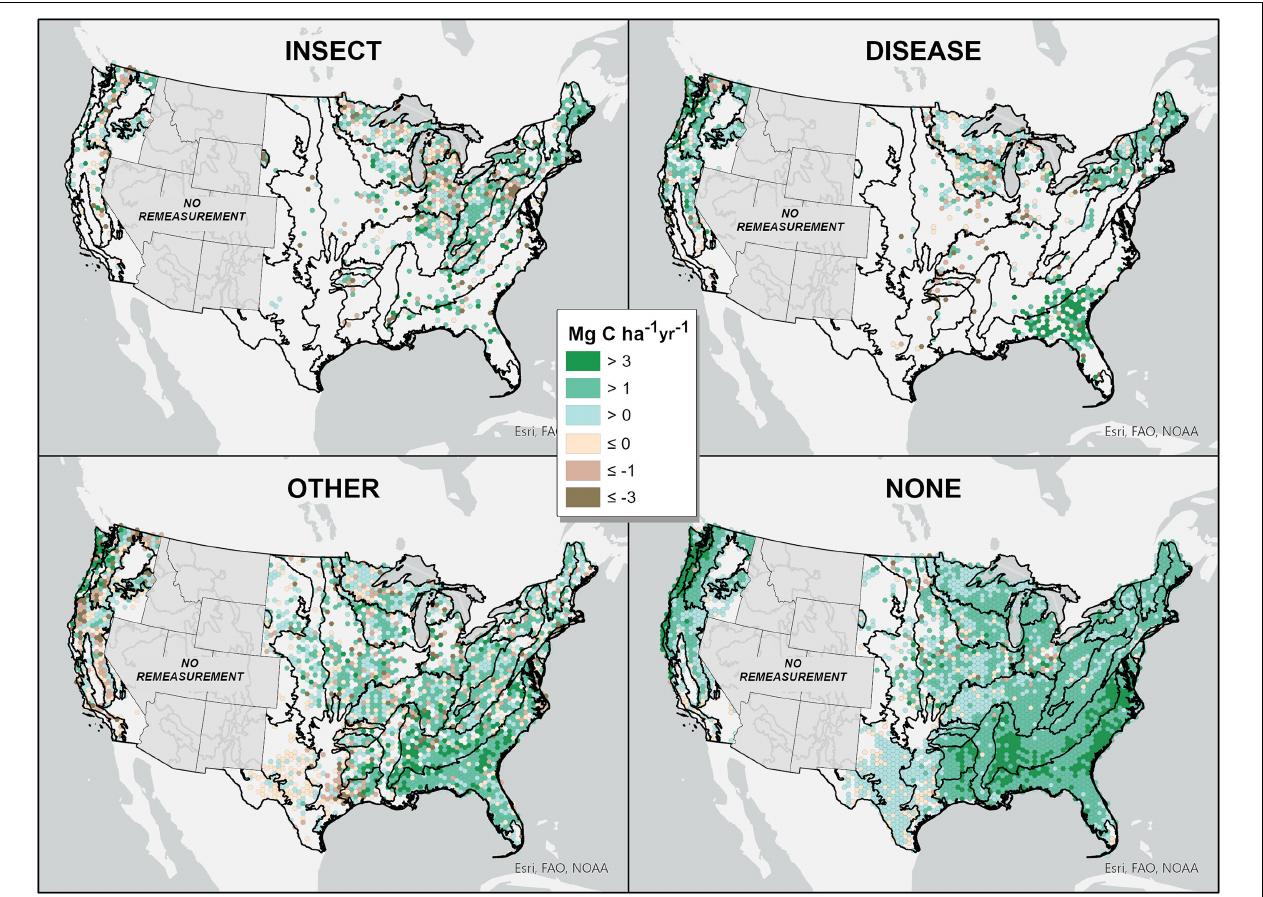
FIGURE 3 | Average annual change in live tree C for NFI plots (aggregated by 144000 ha. hexacell) by dominant disturbance type assigned to each NFI plot across forests of the contiguous US. Map scaling and NFI plot density prohibited visualization of average annual change in live tree C sequestration capacity for individual NFI plots. To visualize trends, NFI plots have been aggregated by 144000 ha. hexacells with average annual change in live tree C values representing the mean of all NFI plots included in each hexacell. Black lines delineate ecoprovince boundaries. Grayed out states (i.e., Rocky Mountain states) contain NFI plots having only one recent live tree C measurement that prohibited their inclusion in our analysis of average annual change in live tree